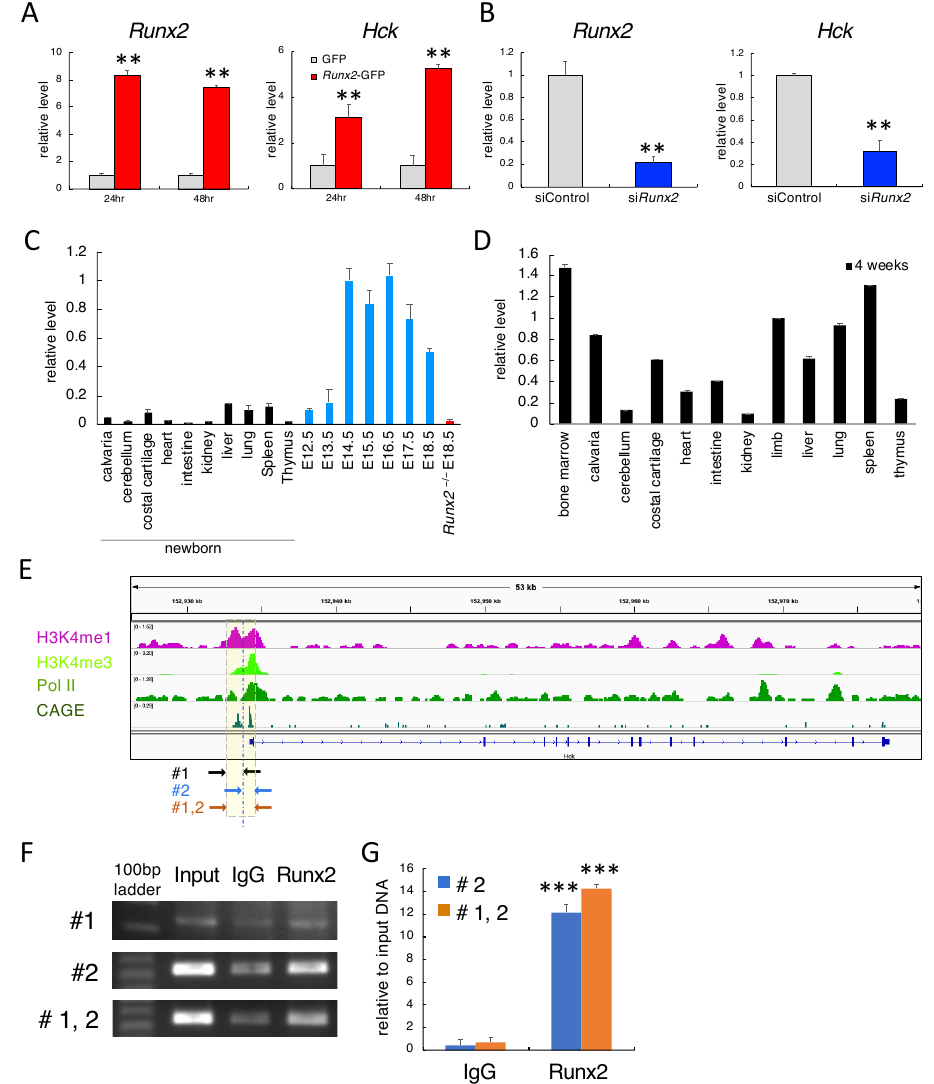
Figure 1. Real-time RT-PCR and chromatin-immunoprecipitation (ChIP) analyses. ( A – D ) Real-time RT-PCR analyses. A , Induction of Hck expression by Runx2. Wild-type primary chondrocytes were infected with adenovirus expressing GFP (grey columns) or Runx2 and GFP (red columns). The values in GFP-expressing cells were defined as 1, and relative levels are shown. n = 4. B , Reduction of Hck by siRNA for Runx2 . Primary chondrocytes were infected with siControl or si Runx2 . The values of siControl were defined as 1, and relative levels are shown. n = 4. ** p < 0.01. C , Abundance of Hck transcripts in tissues of newborn mice, limb tissue in wild-type embryos at E12.5 − 18.5, and Runx2 − / − embryos at E18.5. D , Abundance of Hck transcripts in tissues at 4 weeks of age. Three mice were analyzed for each tissue. The values in limbs at E14.5 ( C ) and 4 weeks of age ( D ) were set as 1, and relative levels are shown. ( E ) Genome browser views of H3K4me1, H3K4me3, and Pol II ChIP-seq, and cap analysis of gene expression (CAGE) profiles in limbs are shown. A yellow dashed box highlights the region of the transcription start site (TSS) of Hck . Two TSS peaks in the CAGE were correctly mapped to the known 5 (cid:48) end in the RefSeq of Hck . The locations of the primer sets (#1, #2, or #1 and 2) used in F and G are shown on the bottom. High-throughput ChIP-seq data sets were obtained from the ENCODE website. ( F and G ) ChIP analysis using ATDC5 cells. DNA before immunoprecipitation (input) and after immunoprecipitation with anti-Runx2 antibody or mouse IgG was amplified by PCR ( F ) and real-time PCR ( G ) using primers shown in E . Three independent ChIP assays were performed and the means ± SD are shown in G. *Versus IgG. *** p <